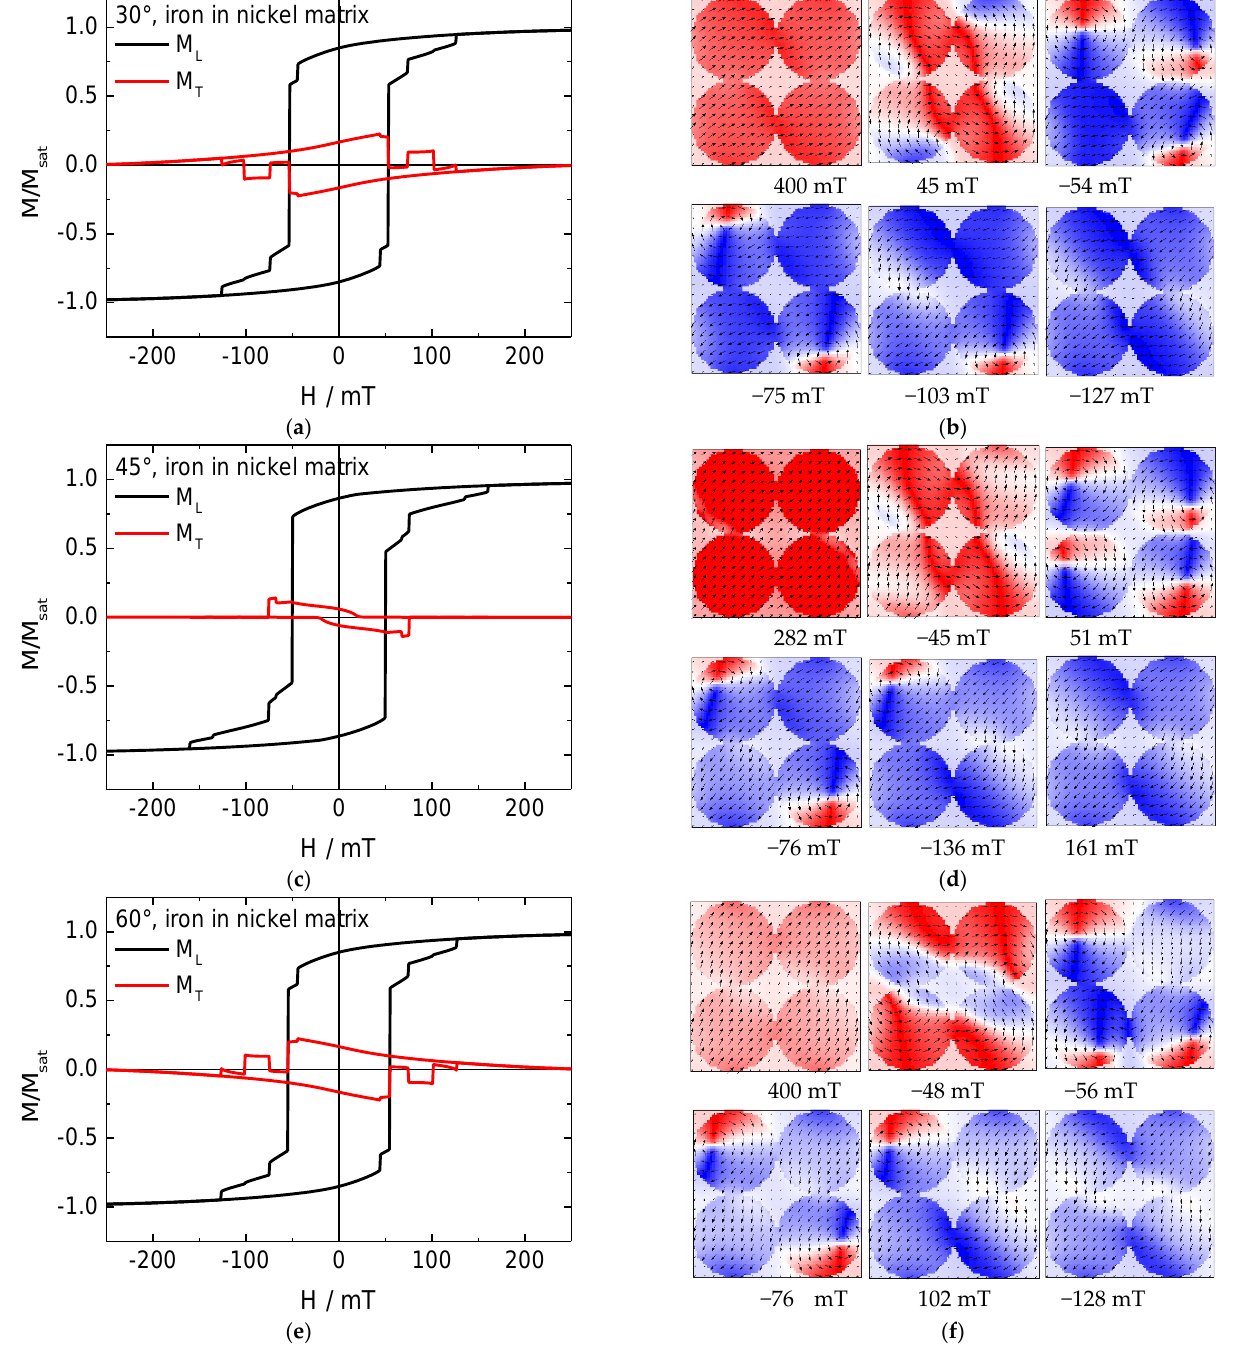
Figure 5. ( a , c,e ) Hysteresis loops and ( b , d,f ) snapshots of the magnetization of the reversal from positive to negative sat- Figure 5. ( a , c , e ) Hysteresis loops and ( b , d , f ) snapshots of the magnetization of the reversal from positive to negative uration for a pure iron nanodot array in a nickel matrix, simulated for the angles depicted in the graphs. saturation for a pure iron nanodot array in a nickel matrix, simulated for the angles depicted in the graphs. For an angle of 30°, on the other hand, there is no step visible, with all four dots be- Testing the reversed matrix, Figure 6 depicts hysteresis loops and magnetization ing in a vortex state simultaneously. For all angles, however, a partly coherent magneti- reversal snapshots from positive to negative saturation of nickel nanodots in an iron matrix. zation reversal is visible by the open transverse hysteresis loop around 0 mT. Here, the behavior is completely different. In the hysteresis loops simulated for 45